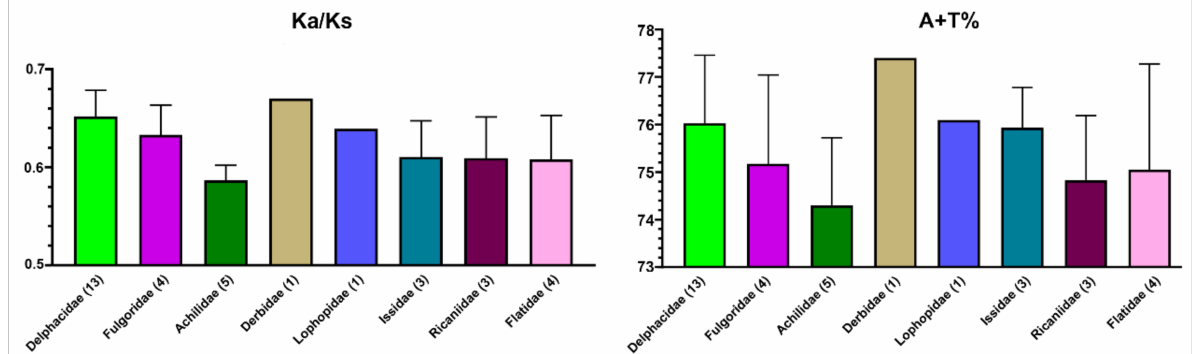
Figure 5. Ka/Ks ratio and A + T content for each family were calculated from the protein-coding genes only. Error bars represent standard deviations in data from multiple species.